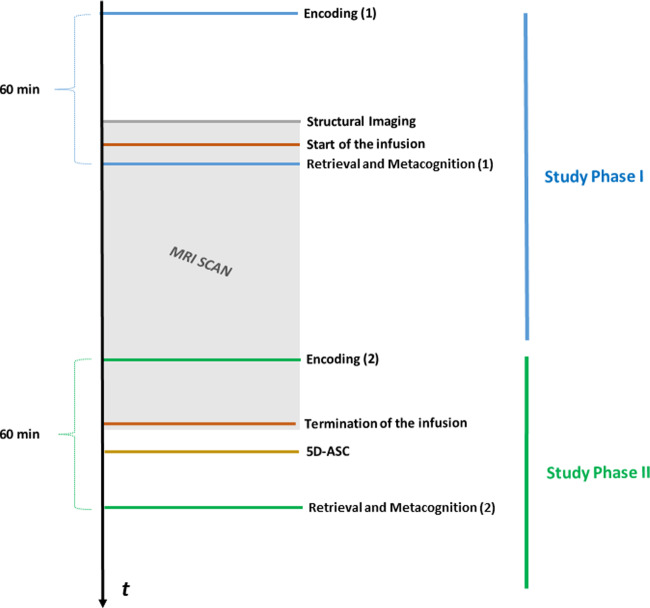
Study protocol. In Study Phase I (shown in blue), participants first encoded word items in the absence of infusion and before entering the MRI scanner. After a medical screening (in purple), participants completed a structural scan (in gray). Following the start of the infusion (in brown), retrieval of encoded items and corresponding metacognitive confidence was tested. As participants were still undergoing infusion in the MRI scanner, in Study Phase II (in green), participants encoded a second word list which was later retrieved outside the scanner, after termination of the infusion. Questionnaire data were collected using the 5D-ASC (in yellow). The MRI scanning period is represented by the grey box.